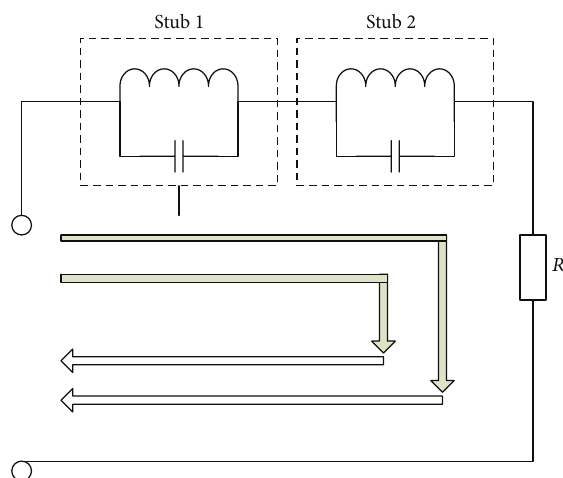
Figure 11: Effect of length of the narrow slot.